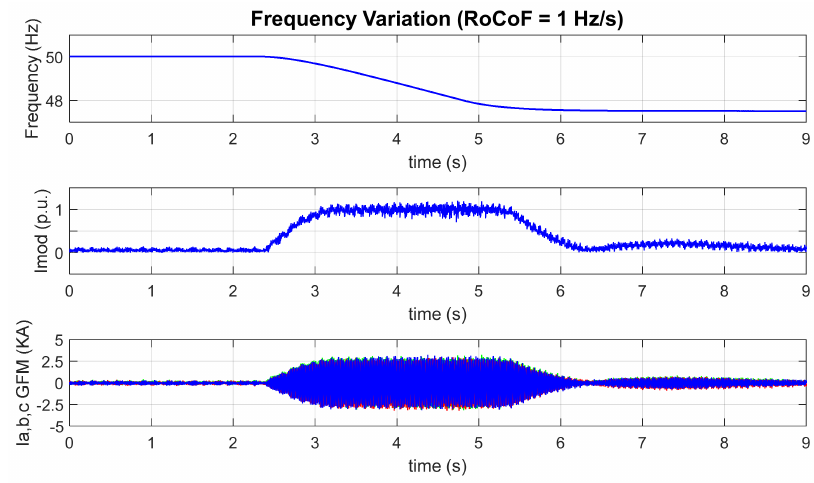
Figure 18. Verification of the operation of the current limiter.